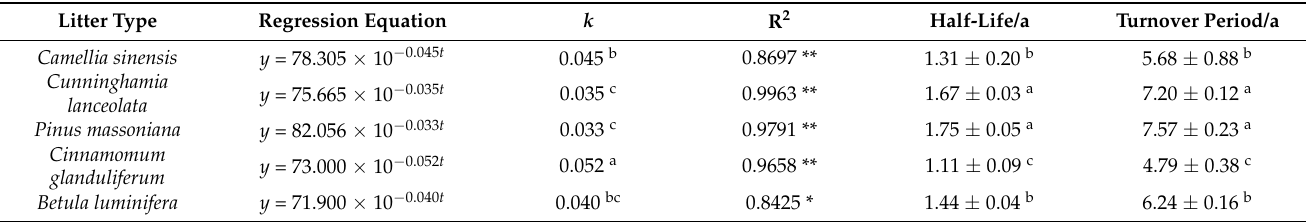
Table 2. Regression model of the loss of dry matter mass for different